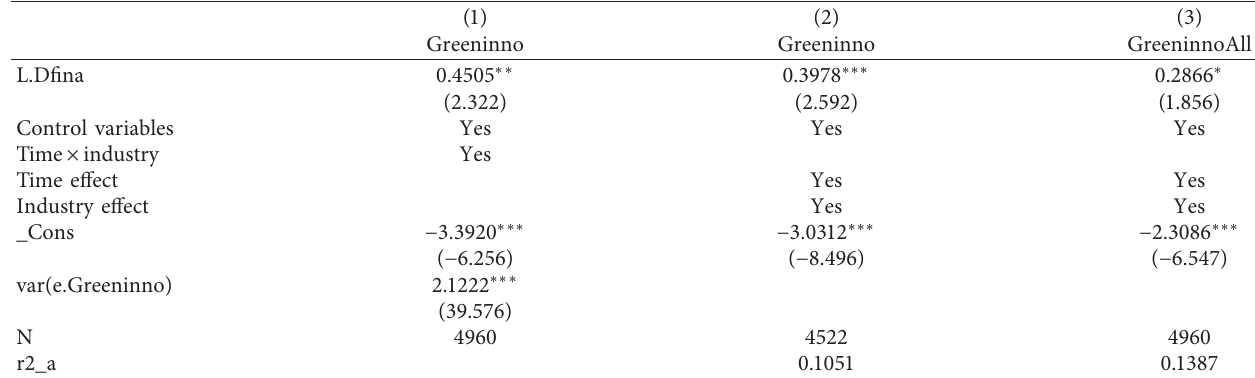
Table 7: Robustness